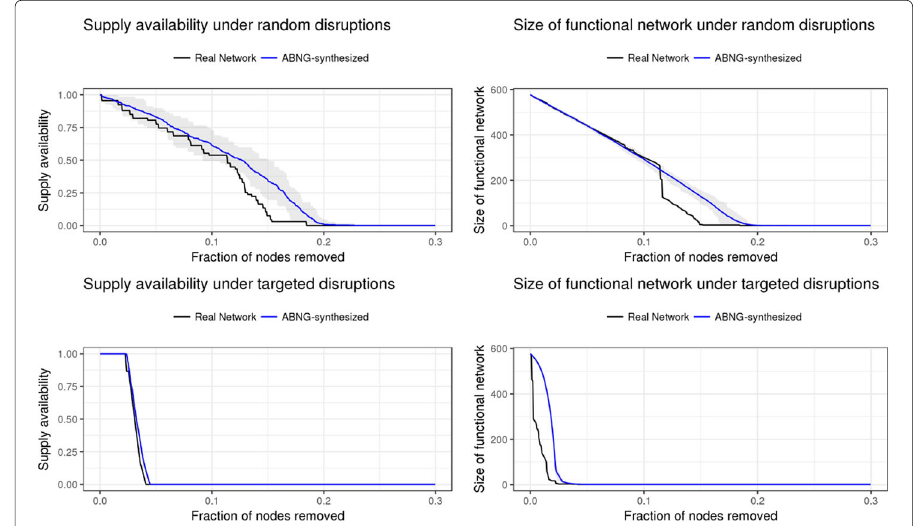
Fig. 8 Supply network of Computer Storage